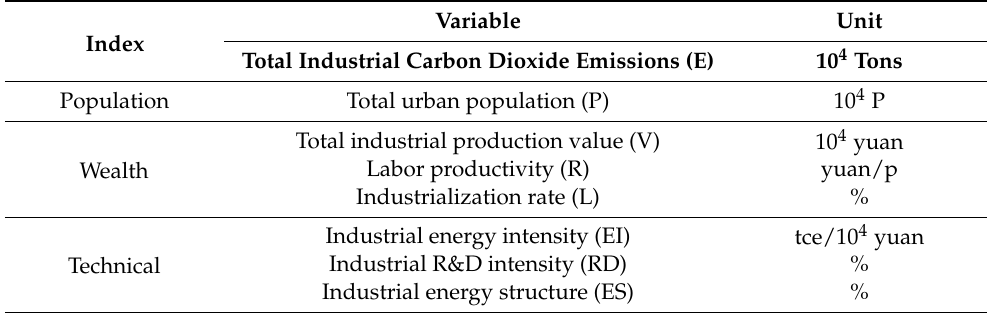
Table 1. STIRPAT model